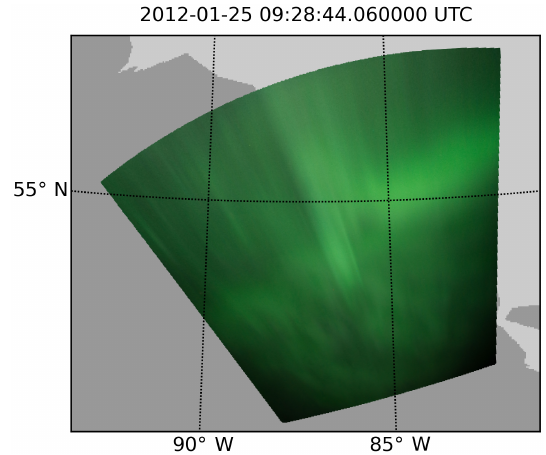
Figure 5. Results of georeferencing and projecting the image in Fig. 1 to 110km